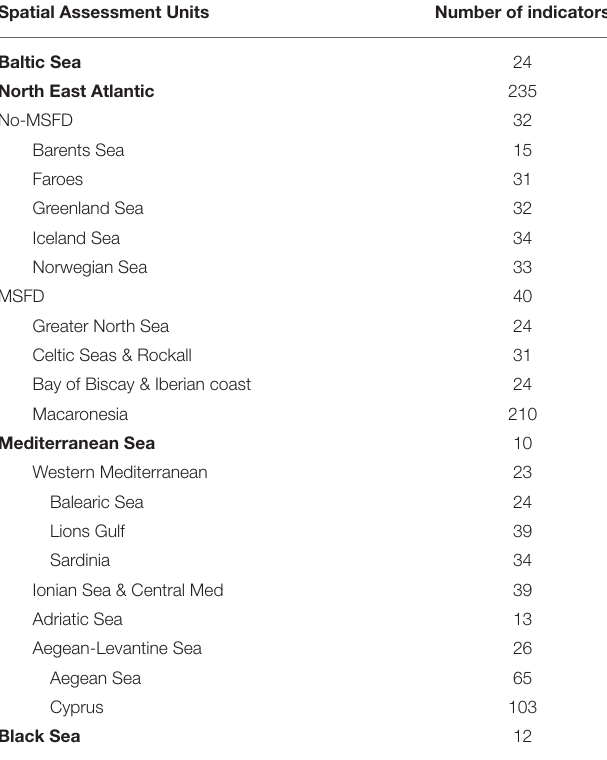
TABLE 5 | Sensitivity analysis of the NEAT assessment, showing the minimum number of indicators needed to achieve the same final assessment when using all the indicators, for each subunit (aligned to the right), subregion (centered), and regional sea (aligned to the left, in